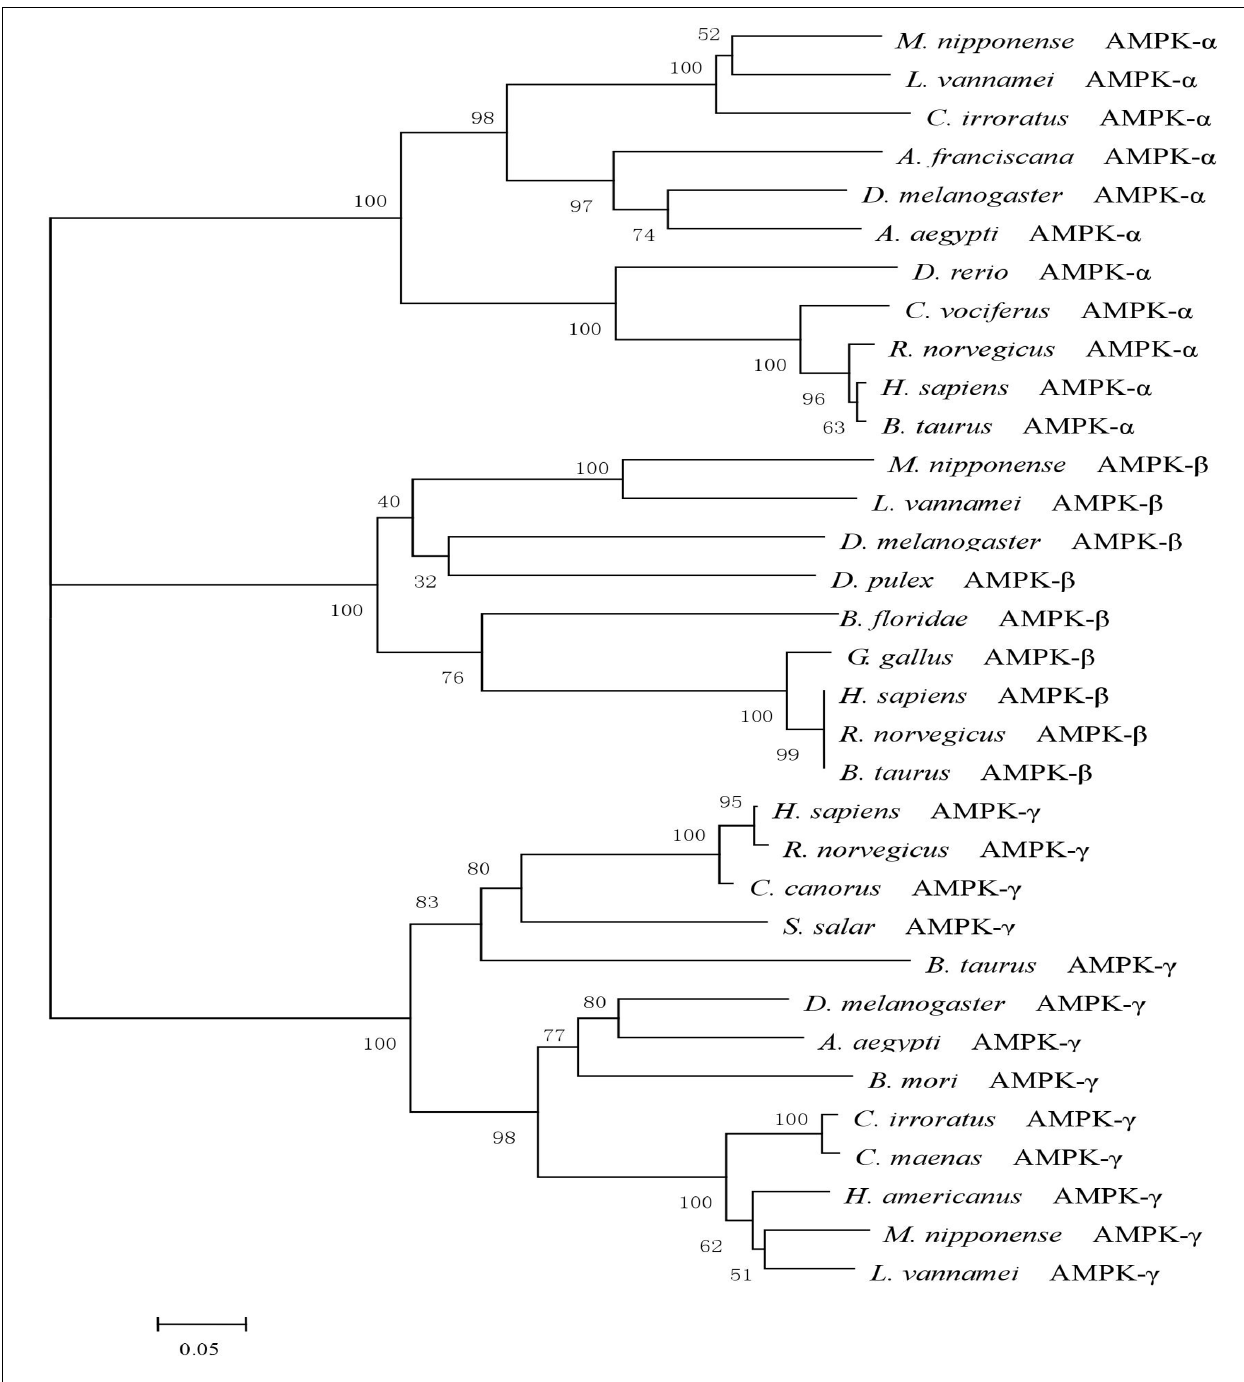
FIGURE 1 | A phylogenetic tree of AMPK was constructed with neighbor-joining method by the program MEGA 6.0. The numbers at each branch indicate the percentage bootstrap values. The amino acid sequences were downloaded from NCBI: Litopenaeus vannamei (AKE50479.1), Homo sapiens (NP_006243.2), Rattus norvegicus (NP_076481.1), Bos taurus (NP_001192534.1), Charadrius vociferous (KGL92907.1), Danio rerio (NP_001103756.1), Drosophila melanogaster (NP_726730.1), Aedes aegypti (XP_001652572.1), Cancer irroratus (ACL13568.1), Artemia franciscana (ABI13783.1), Litopenaeus vannamei (AKE50480.1), Homo sapiens (NP_005390.1), Rattus norvegicus (NP_072149.1), Bos taurus (NP_001179257.1), Gallus gallus (NP_001038127.1), Branchiostoma floridae (EEN66070.1), Drosophila melanogaster (NP_610460.1), Daphnia pulex (EFX67948.1), Litopenaeus vannamei (AKE50481.1), Homo sapiens (NP_001035723.1), Rattus norvegicus (NP_908940.1), Bos taurus (NP_001025473.2), Cuculus canorus (KFO74243.1), Bombyx mori (NP_001119720.1), Salmo salar (ACI33670.1), Drosophila melanogaster (NP_732599.1), Aedes aegypti (XP_001659398.1), Cancer irroratus (ACL13567.1), Homarus americanus (AEO22037.1), and Carcinus maenas